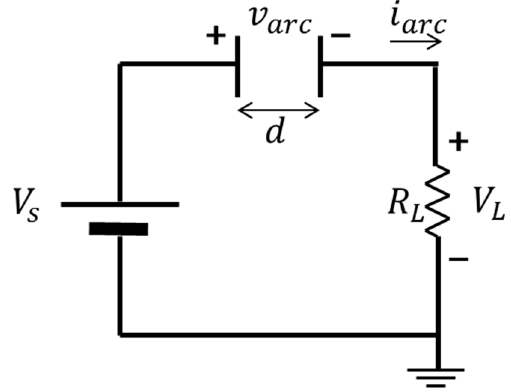
Figure 2. Direct current (DC) arc experiment circuit.